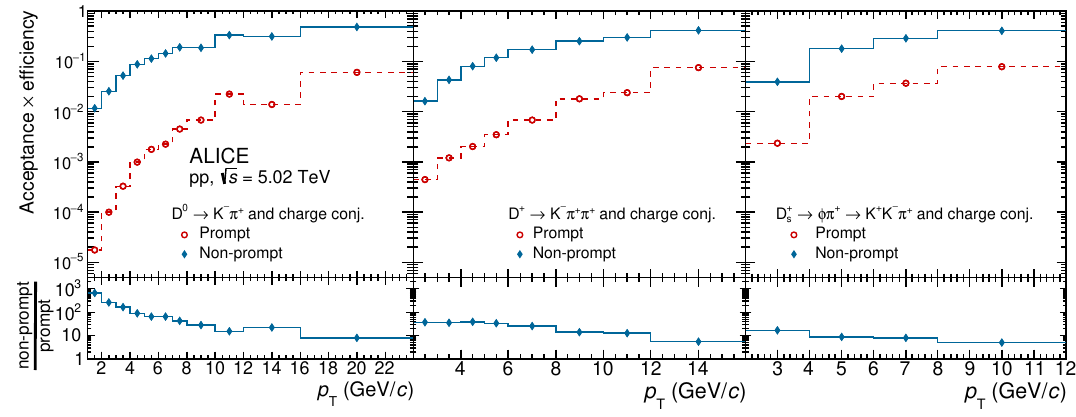
mesons as a function of p T . The s